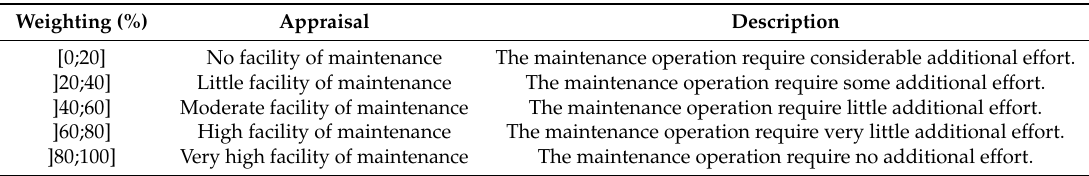
Table 2. Evaluation of the easiness indicator (Eid).